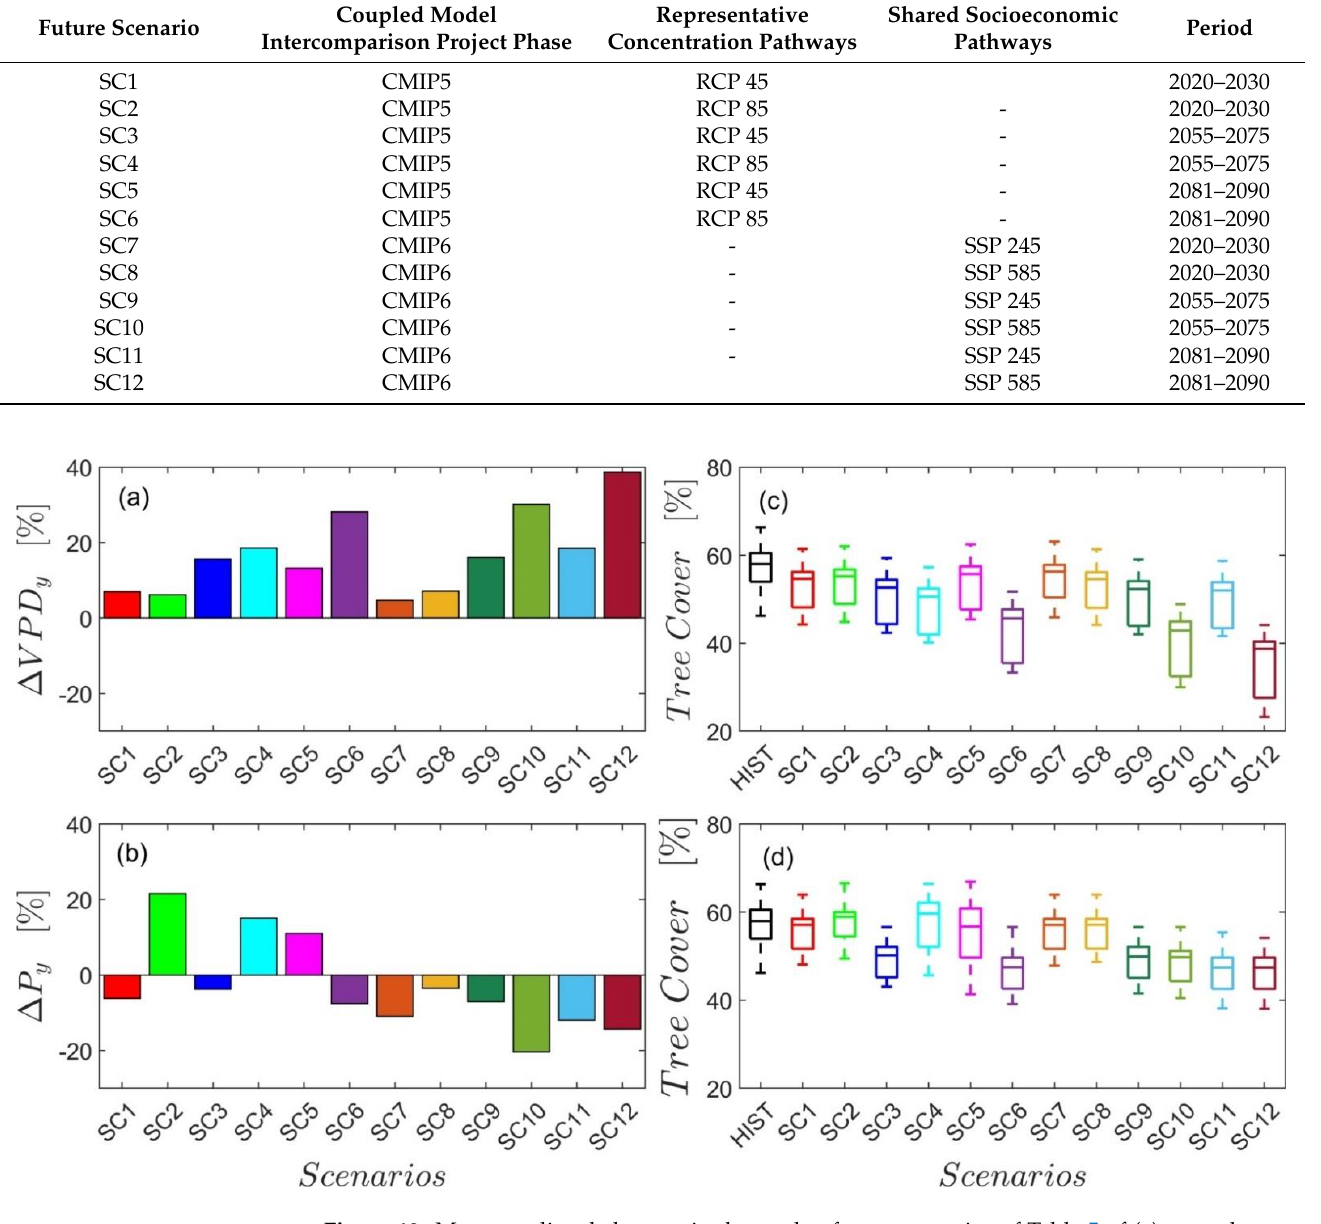
Figure 10. Mean predicted changes in the twelve future scenarios of Table 5 of ( a ) annual vapor- pressure deficit ( ΔVPD y ) and ( b ) annual precipitation ( ΔP y ) in Sardinia. Variation in tree cover with respect to the historical value in the twelve scenarios due to the variation in VPDy alone ( c ) and in Py alone ( d ).